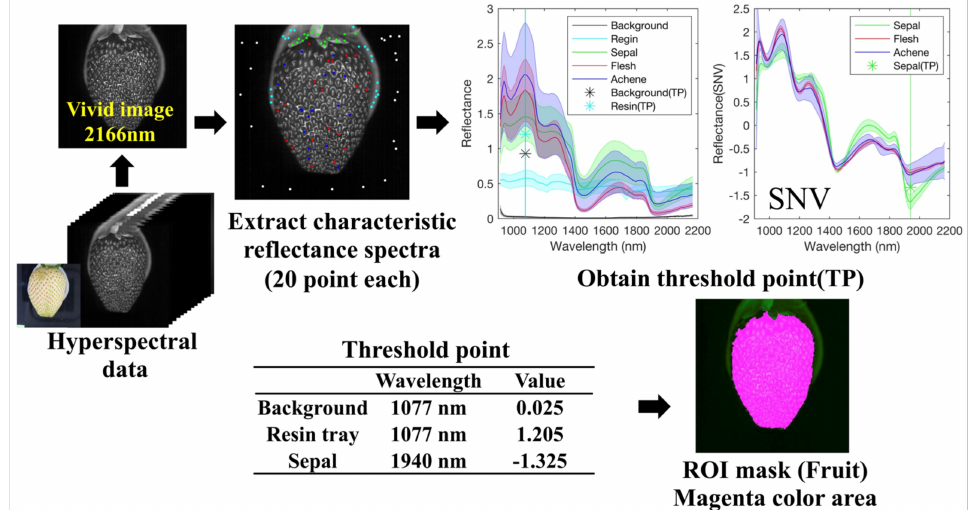
Figure 2. Preprocessing procedure for hyperspectral data with ROI extraction by thresholding (Fruit